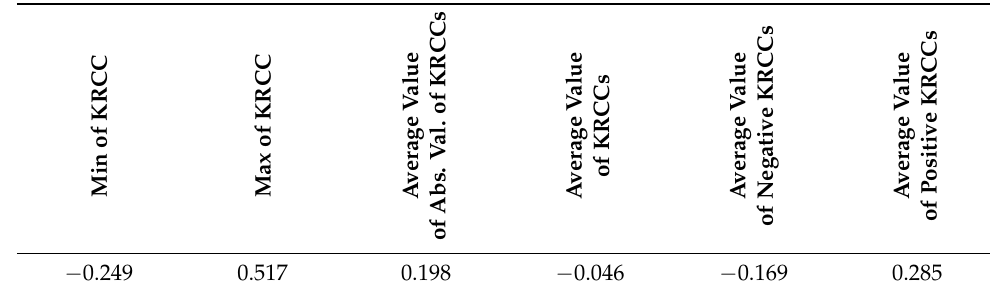
Table 4. Detailed Characteristics of SSCRs between Nodal Reactive Powers and Nodal-Voltage